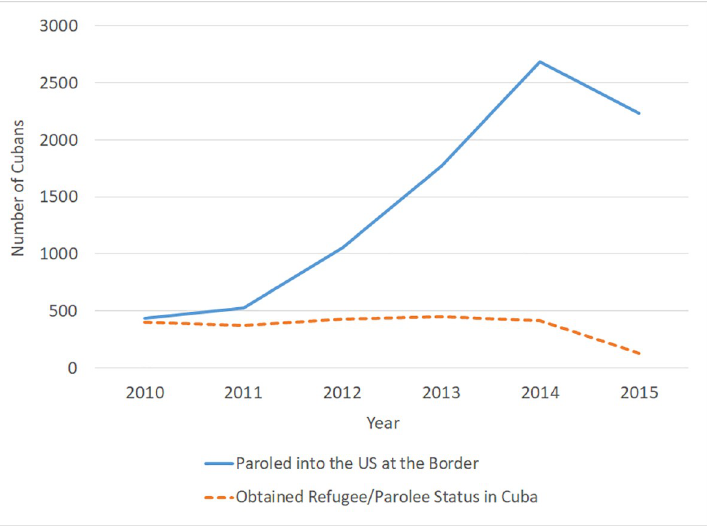
Fig 1. Number of Cubans entering the US and settling in Texas during 2010–2015 by entry route.